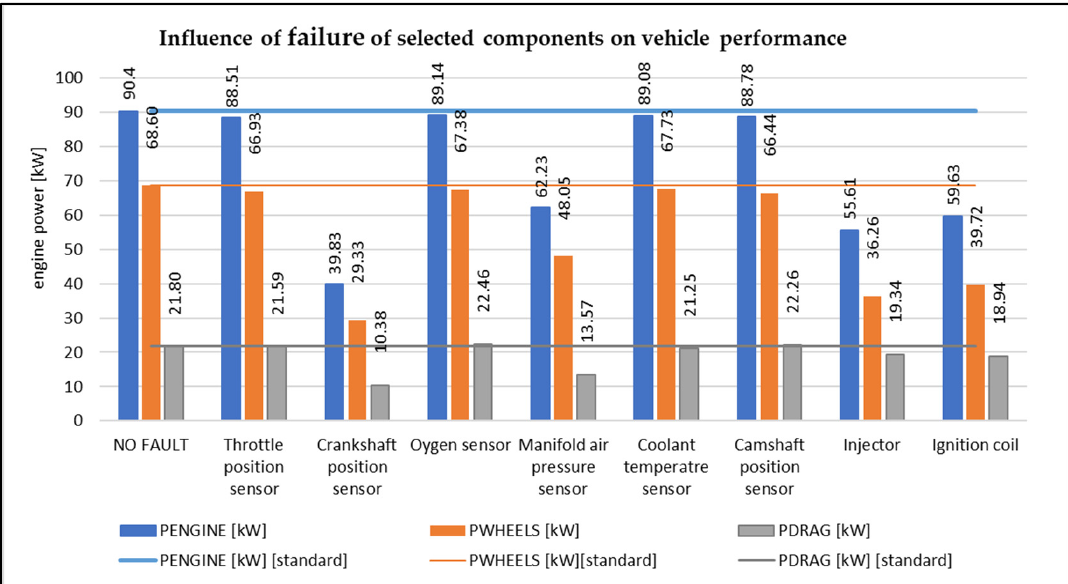
Figure 3. Influence of failure of selected components on vehicle performance (author).